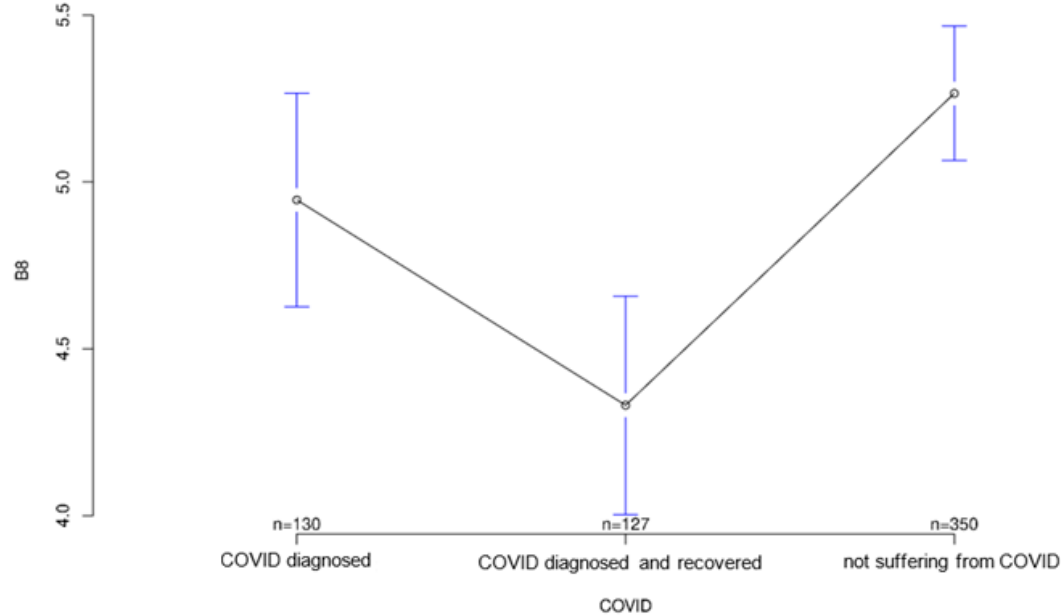
Figure 10. Average agreement with statement 8 of the COVID-specific questionnaire: “I have security concerns (e.g.,